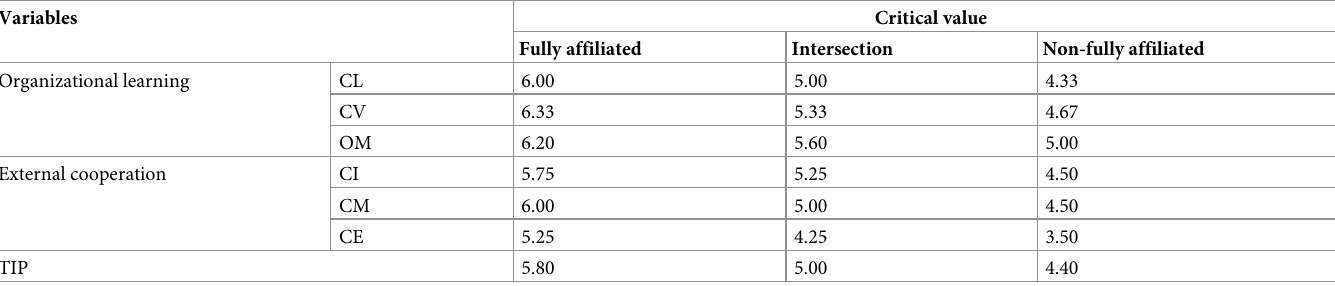
Table 3. Calibration thresholds for